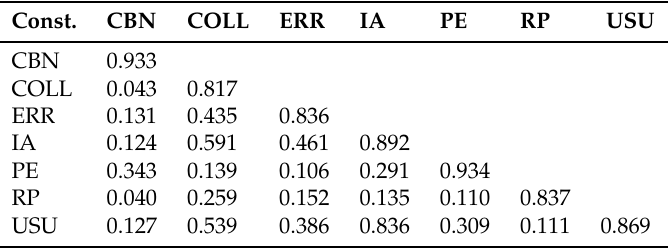
Table A3. Discriminant validity with AVEs and construct Correlations ( diagonal; construct correlations are off-diagonal